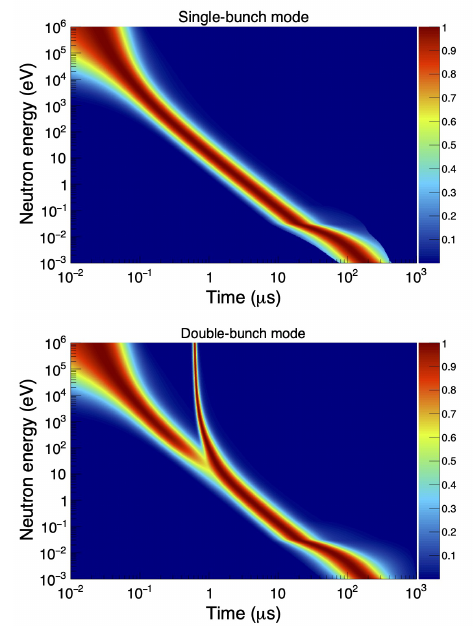
Figure 2. Resolution functions of the J-PARC / MLF facility in the single- and double-bunch modes calculated by the AMUR code base on the work of Kino et al.